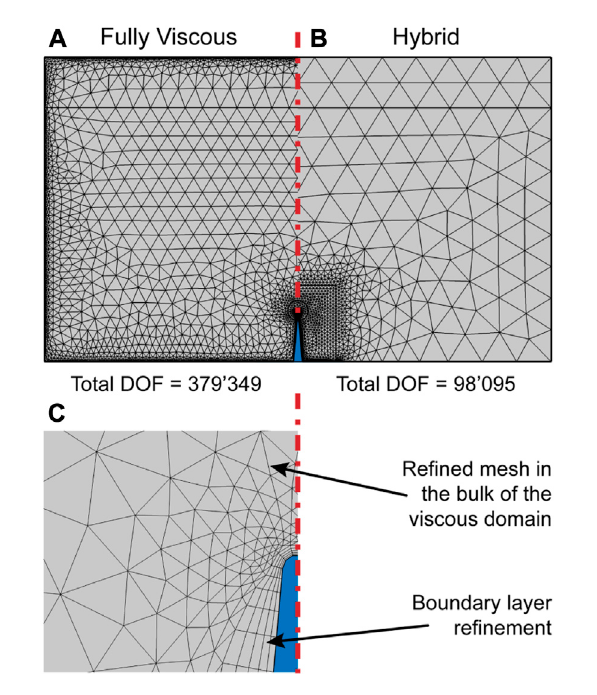
FIGURE 3 Comparison of the converged meshes of (A) the Fully Viscous model with the total DOF of 379 ′ 349 and (B) the Hybrid model with the total DOF of 98 ′ 095 at f = 720 kHz in water, with a = 1 mm, h = 100 μ m, α = 10 ° , and b = 150 µm; (C) closeup of the mesh of the Hybrid model near the sharp-edge tip, where the viscous boundary layer mesh is